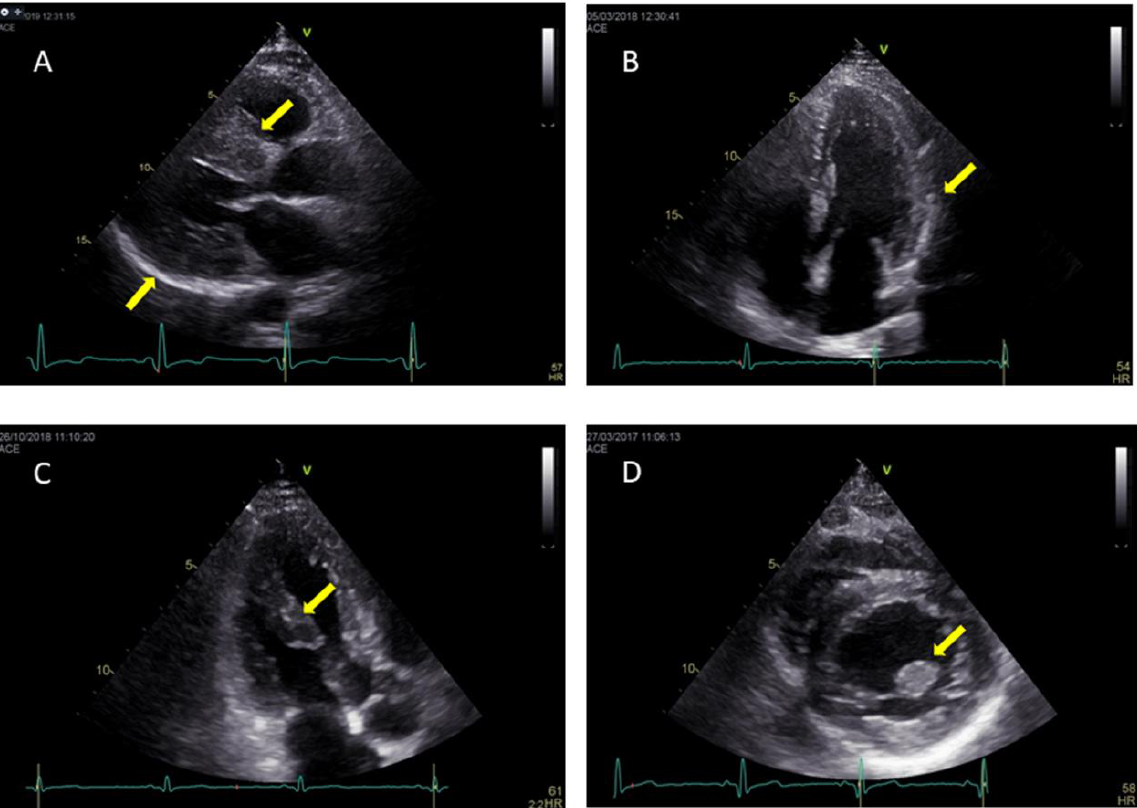
Figure 1. Parasternal long axis shows symmetrical hypertrophy in AFD patient ( A ); echocardiographic binary sign of left ventricular endocardial border in AFD patient ( B ); hypertrophy of papillary muscles in AFD patient: in apical long axis view ( C ) and in parasternal short axis ( D ).